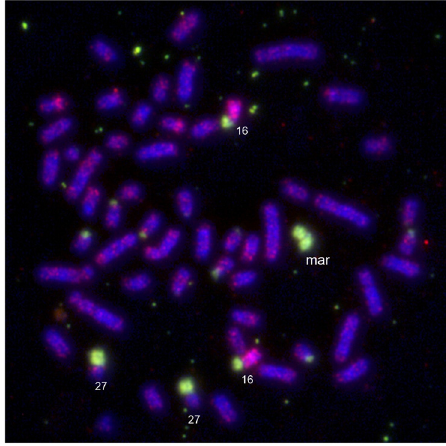
Figure 6. Co-hybridization of the EMAM1 (green) and HSA13 probes (red) to metaphase chromo- somes of E. maximus (2n = 57,XX,+mar). The HSA13 probe shows signals on the EMA16 chromosome. The chromosomes are counterstained with DAPI (blue).